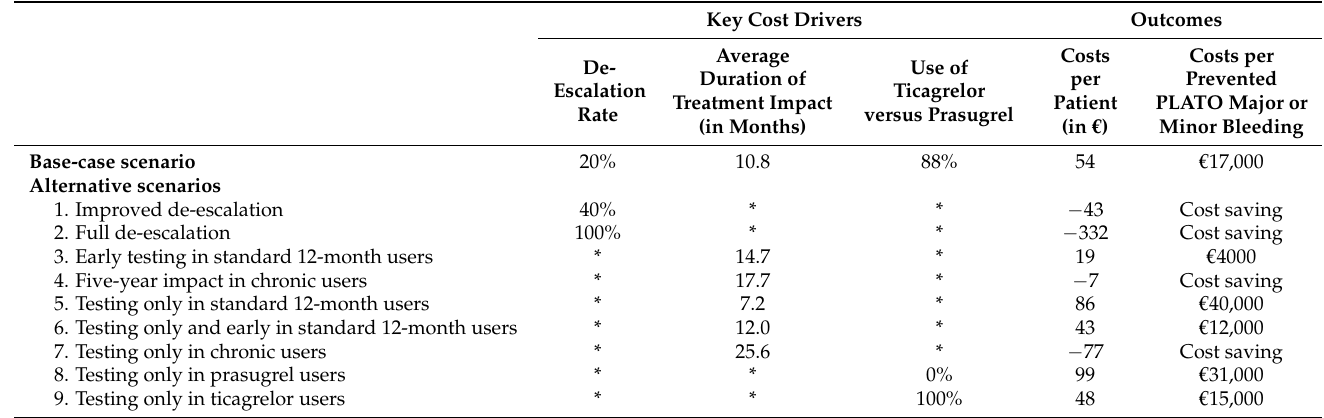
Table 3. Average costs due to POC PGx testing, depending on key cost